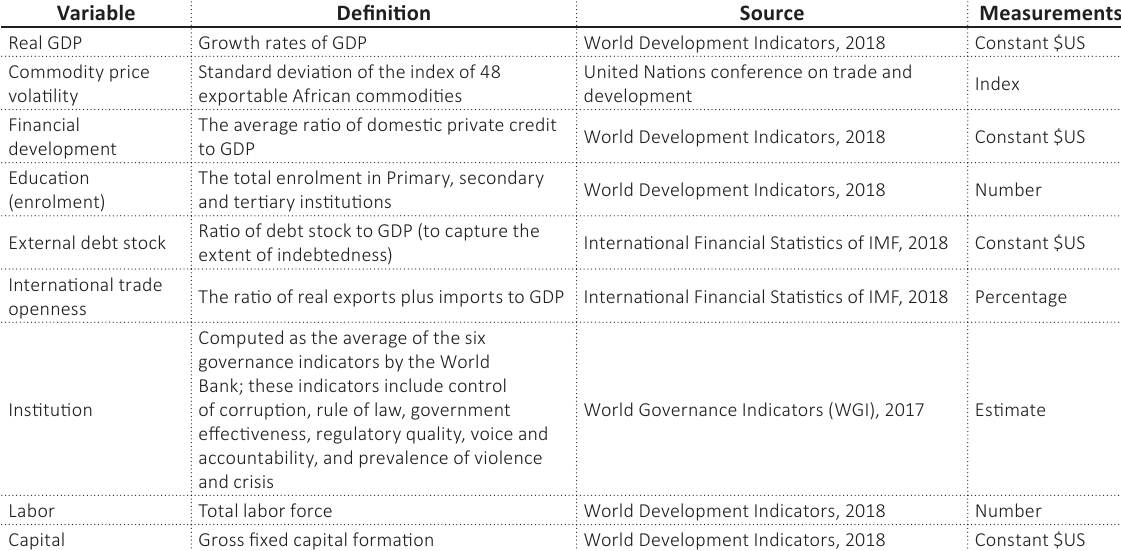
Source: Compiled by the